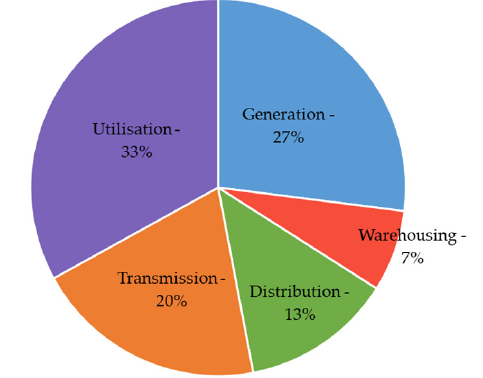
Figure 10. Selected survey results—an analytical–political perspective: do you intend to make changes to the province’s energy policy in order to make it more energy independent?